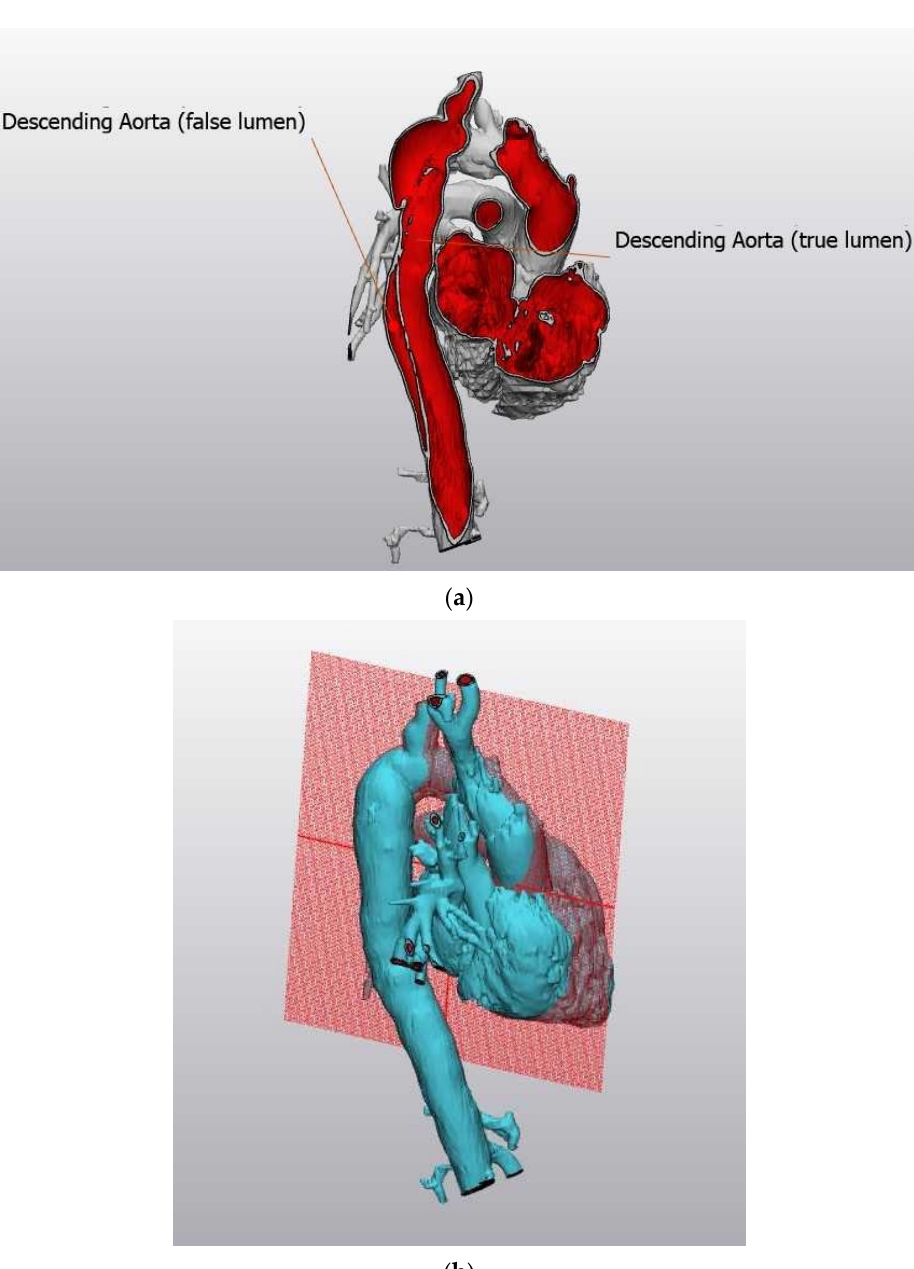
Figure 2. ( a ) Three-dimensional reconstruction of aortic dissection that occurred in a young woman with Turner syndrome. ( b ) Plane of reference for Figure 2a.